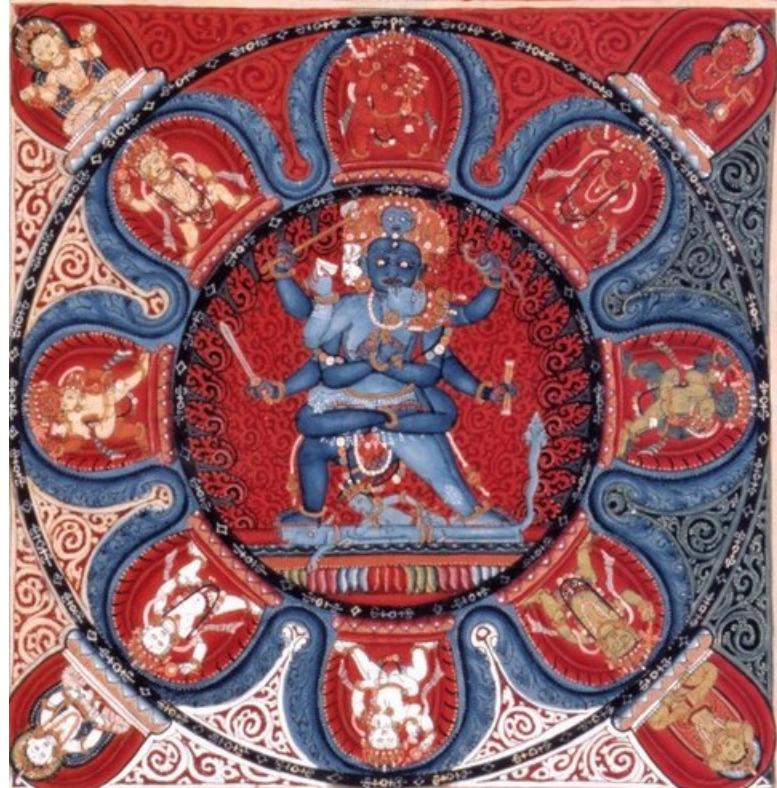
Figure 4. Kr.s.n. ayam¯ari man. d. ala . In the center is the figure Yam¯antaka / Dves.avajrayam¯ari. Encircling him are the eight other yam¯ari s: in the East Mohavajrayam¯ari, in the South Pi´sunavajrayam¯ari, in the West R¯agavajrayam¯ari, and in the North ¯Irsy¯avajray¯amari. Between them in the intermediate directions are Mudgarayam¯ari, Dan.d. ayam¯ari, Padmayam¯ari, and Khadgayam¯ari. In the corners outside of this circular array are the yogin¯ı s, Vajracarcik¯a, Vajrav¯ar¯ah¯ı, Vajrasarasvat¯ı, and Vajragaur¯ı, according to Kum¯aracandra’s description (Rinpoche and Dvived¯ı 1992, pp. 1–4, 8). (Himalayan Art Resource, Item